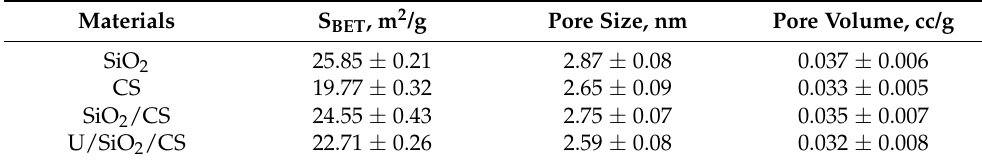
Table 1. Surface parameters of SiO 2 , CS, SiO 2 /CS, and U/SiO 2 /CS.